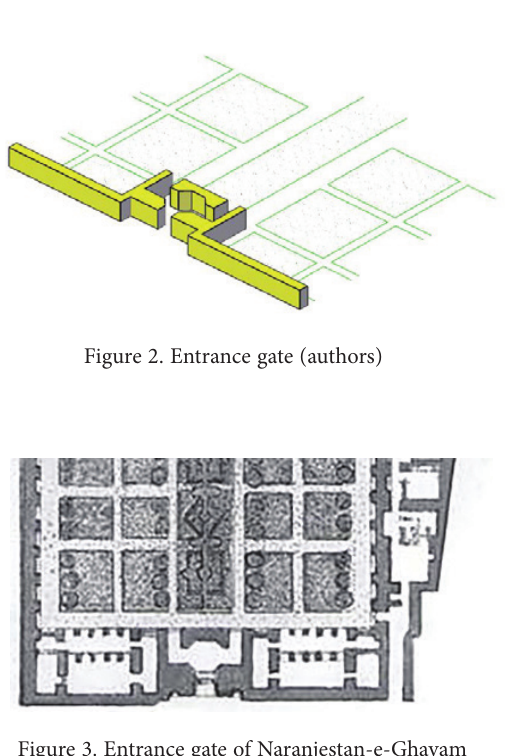
Figure 3. Entrance gate of Naranjestan-e-Ghavam (Naima, 2011, p.